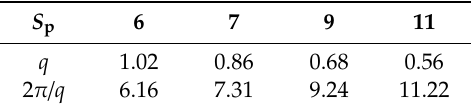
Table 4. Values of wavevector q , at which the hump is observed and corresponding 2 π / q values for di ff erent post separations S p